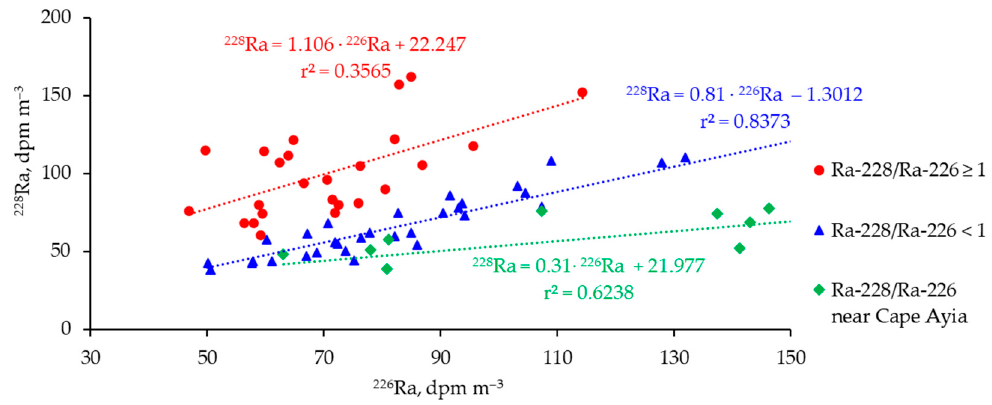
Figure 7. 228 Ra/ 226 Ra ratio in the 116 cruise study area in comparison with the submarine groundwa- ter source region near Cape Ayia.